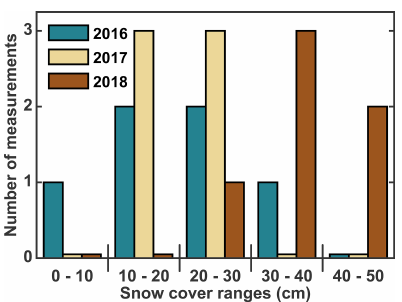
Figure 3. March snow depth distribution on top of the Šuoššjávri peat plateau for 2016, 2017 and 2018. Data for 2016 are from Mar- tin et al. (2019). Measurement locations are displayed in Fig.